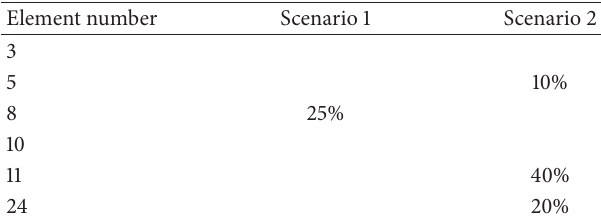
Table 5: Simulated damage scenarios in Bowstring